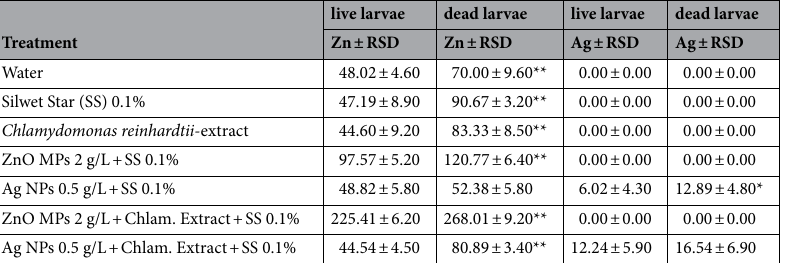
Table 2. The total content of Zn and Ag ions in bodies of live and dead larvae measured by atomic absorption spectrometry (AAS) with flame atomization and with air-acetylene flame and using ultrasensitive hollow cathode lamp as the radiation source of Zn (213.9 nm) and Ag (328.1 nm). The data were statistically analyzed (dead to live larvae) by one-way ANOVA variance test with subsequent Tukey’s multiple comparison test. The asterisks represent statistically significant differences (* = p < 0.05, ** = p < 0.05).